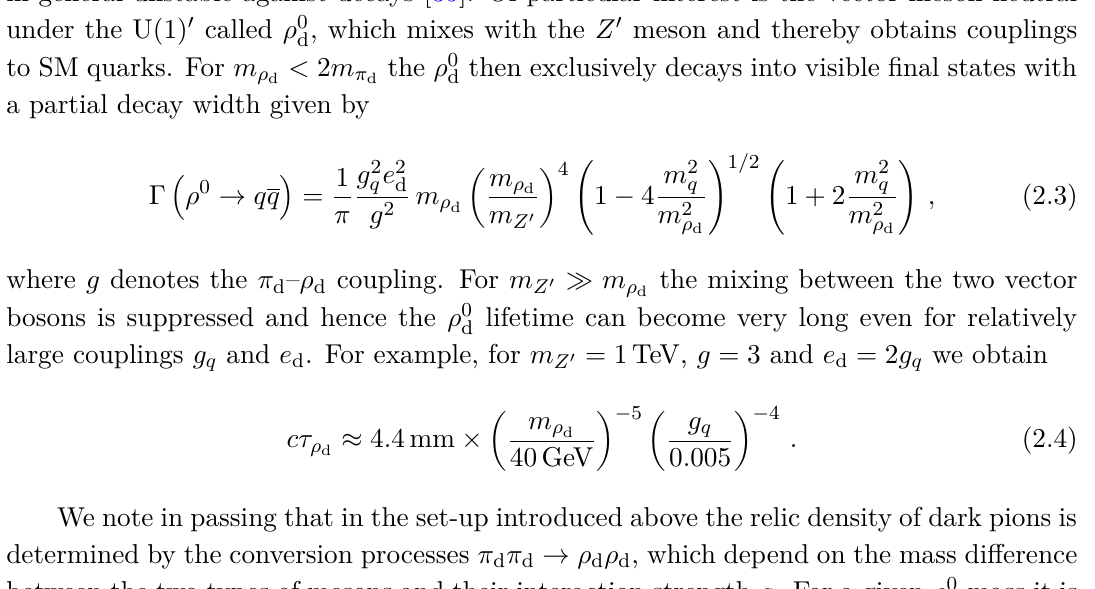
Figure 1 . Diagram of typical LHC signal event containing a dark shower. The ρ 0 SM quarks, while the other mesons escape from the detector as missing energy. Figure taken from ref.